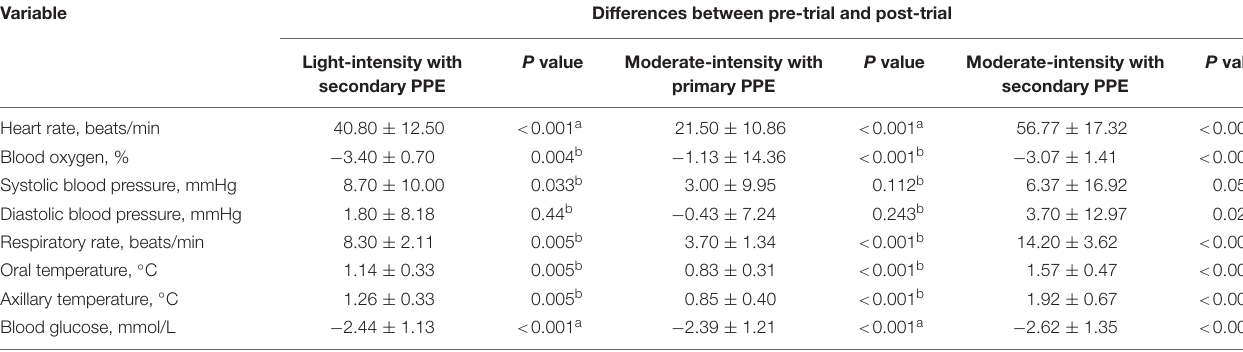
TABLE 4 | Analysis of the physiological index changes of participants between pre-trial and post-trial. Variable Differences between pre-trial and